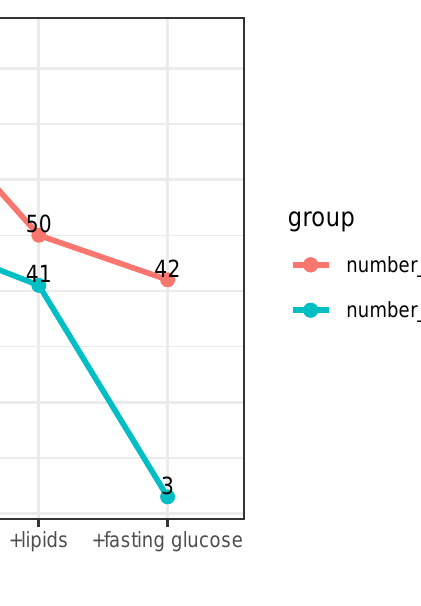
Figure 1. The number of metabolites significantly associated with BMI and T2D in different models after multiple testing correction. The first coordinate on x -axis shows basic model building upwards with including lifestyle, blood pressure, lipids, and fasting glucose parameters as covariates in the model. The y -axis depicts a number of significant metabolites resulting from each model as indicated on x -axis. Lifestyle includes smoking status and physical activities. BP: systolic blood pressure; lipids include HDL cholesterol (HDL-C) and